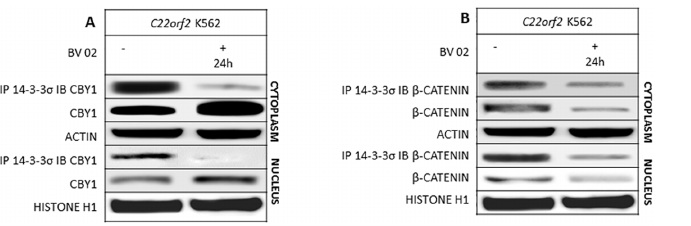
Fig 2. The dissolution of CBY/14-3-3 σ complex in response to BV02, an inhibitor of 14-3-3 binding modes I and II, is associated with a CBY1 increment in the cytoplasmic and nuclear compartment. A- CBY1 expression and interaction with 14-3-3 σ and β catenin expression and interaction with 14-3-3 σ were assayed in the cytoplasmic and nuclear compartments of C22orf2 K562 cells at 24 th hour of exposure to BV02. See legend to Fig 1 for technical